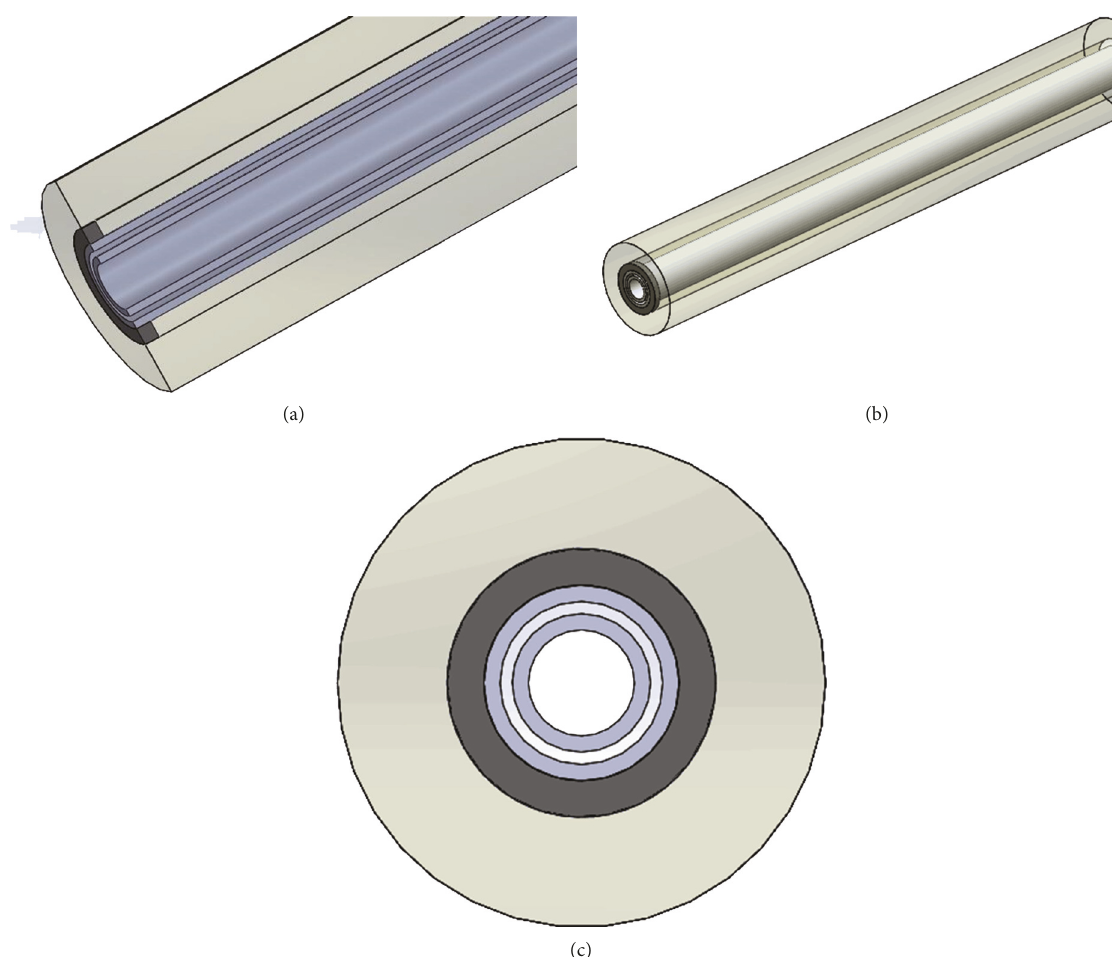
Figure 2: Schematic diagram of the geometric model used in the CFD numerical simulation. Table 1: Specifications of the CFD numerical simulation elements. Wellbore diameter